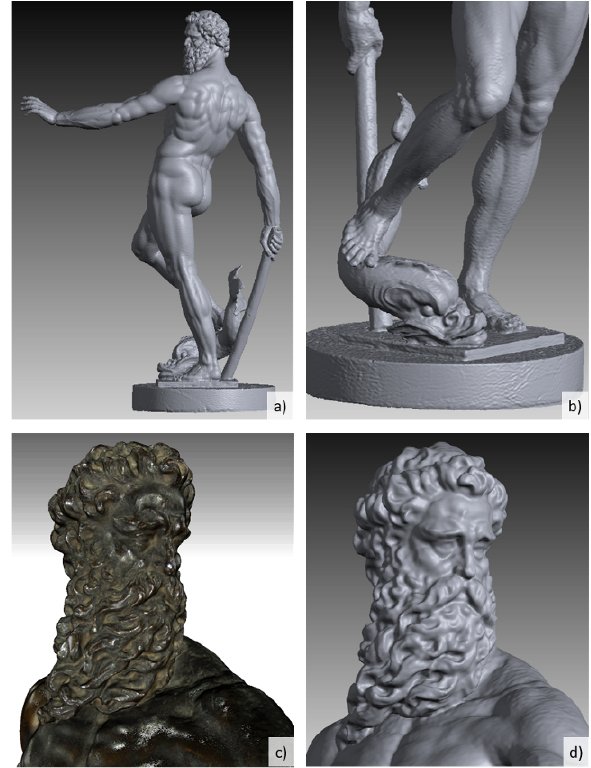
Figure 8. The final 3D model of the archetype of the statue of Neptune (a), with some details: the base of the statuette (b); the head, in photo-textured (c) and shaded view